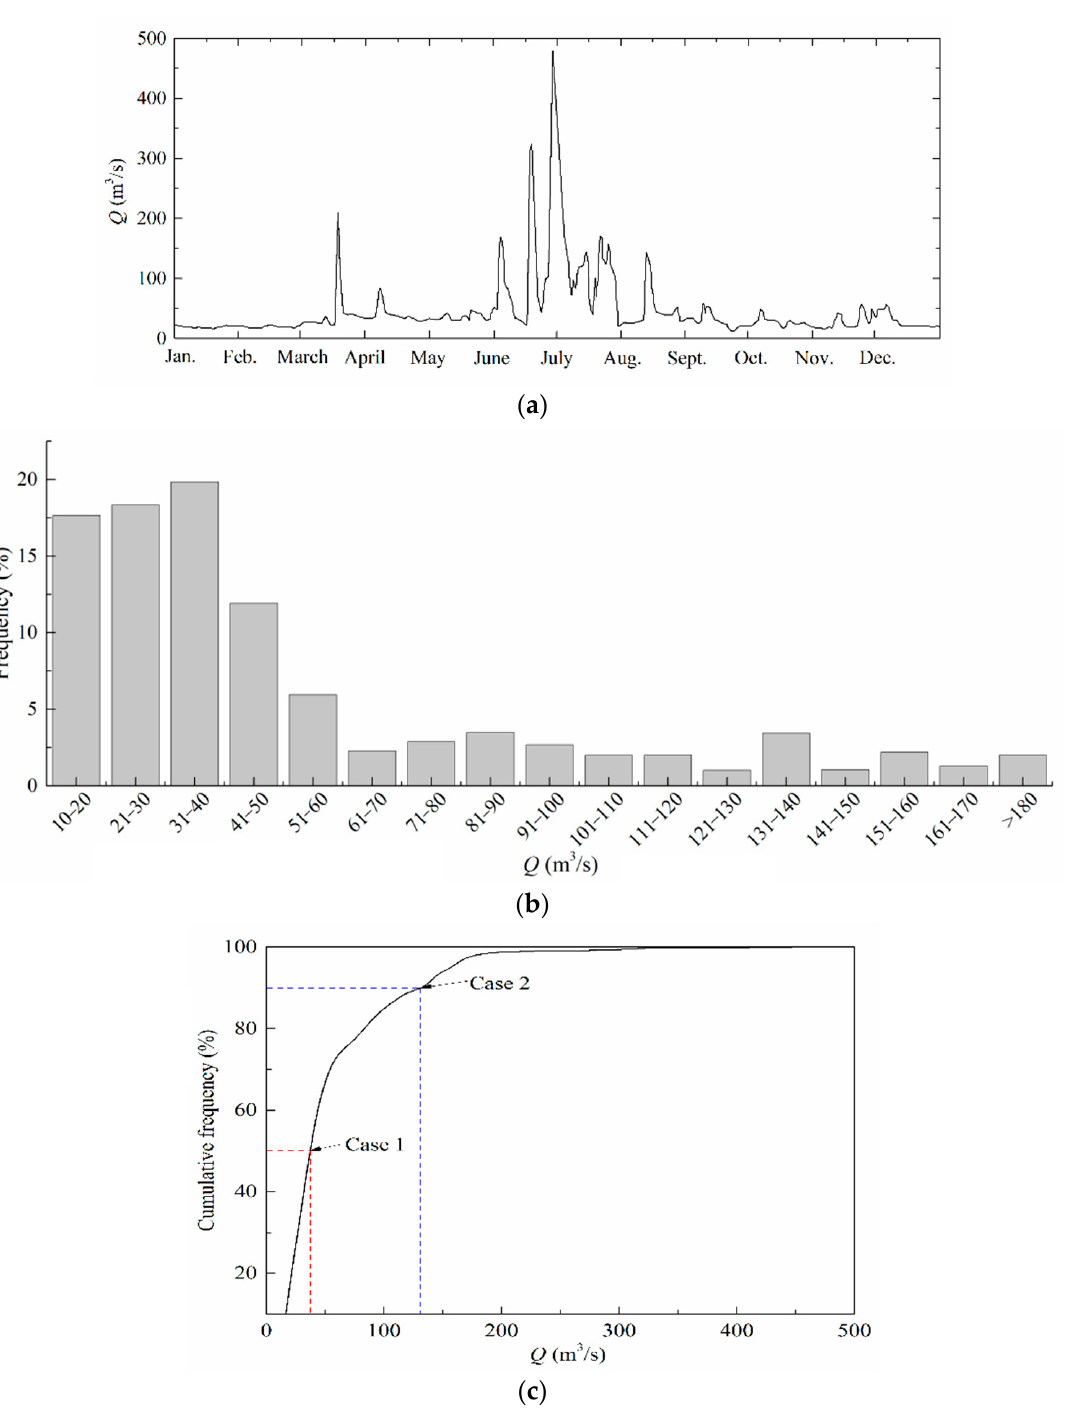
Figure 4 . Hydrological data at the sluice site. ( a ) Multiyear averaged flow discharge; ( b ) flow frequency at a 10 m 3 /s interval; ( c ) cumulative flow frequency.